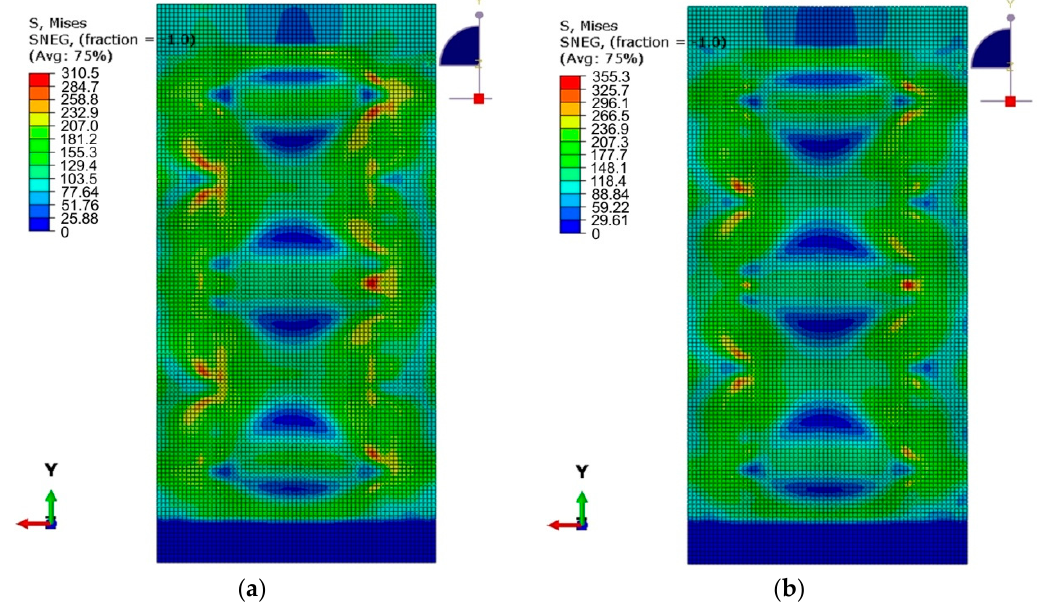
Figure 13. Comparison of the equivalent plastic stress on the outside of the stiffened panel subjected to a compressive force of 0.5 F max : ( a ) welded variant ( s = 29.5 mm), ( b ) riveted variant ( s = 23.5 mm).